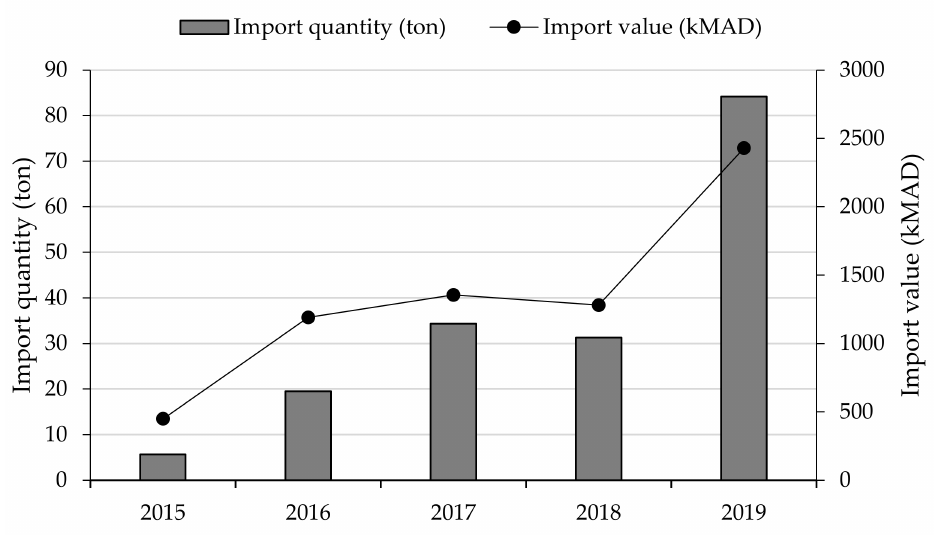
Figure 3. Evolution of quinoa import in Morocco in terms of quantity and value. 1 USD = 9 MAD.